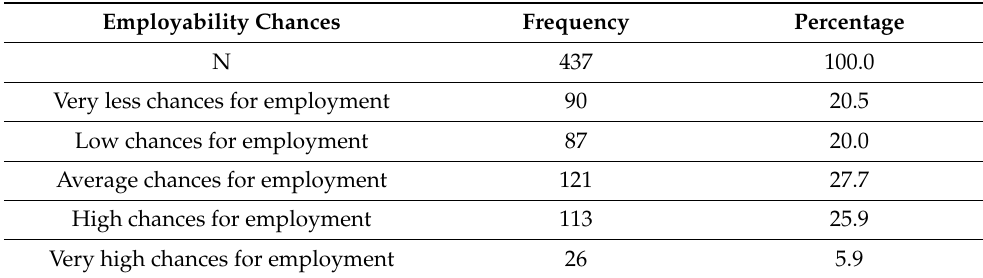
Table 7. Frequency of employability chances based on existing skills